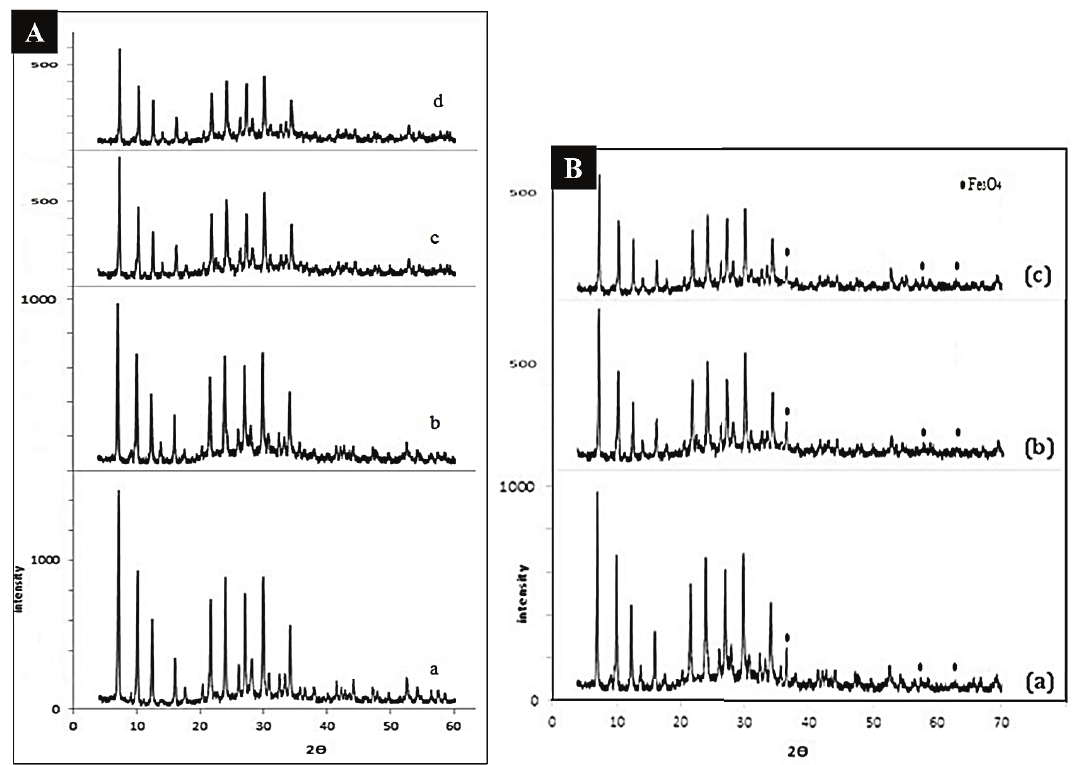
Figure 1: XRD patterns of: A) a: zeolite 4A, b: DOX 4.7 @ 4A, c: DOX 42.5 @ 4A, d: DOX 80 @